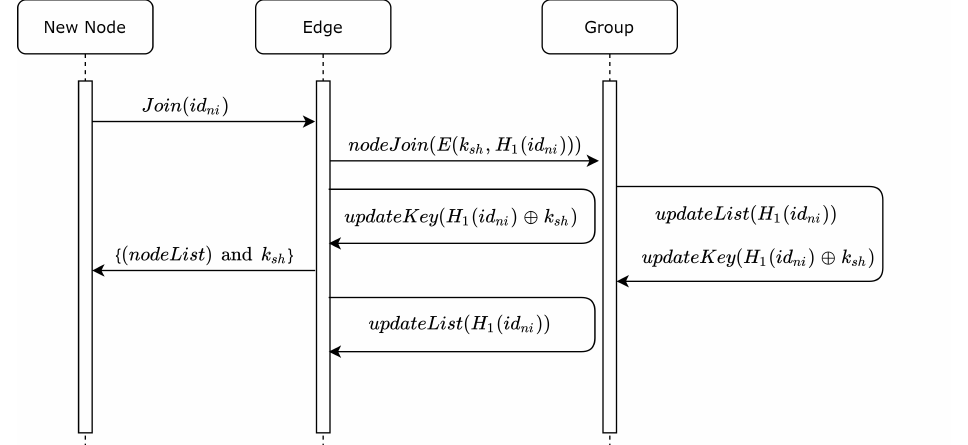
Figure 3. Sequence diagram for new node joining the group.